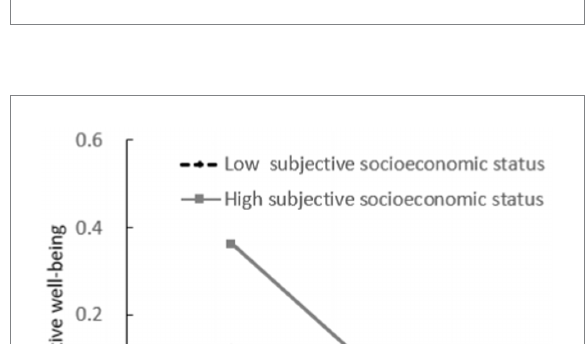
FIGURE 3 Interactive effects of gender role attitude and education levels on parental sacrifice.